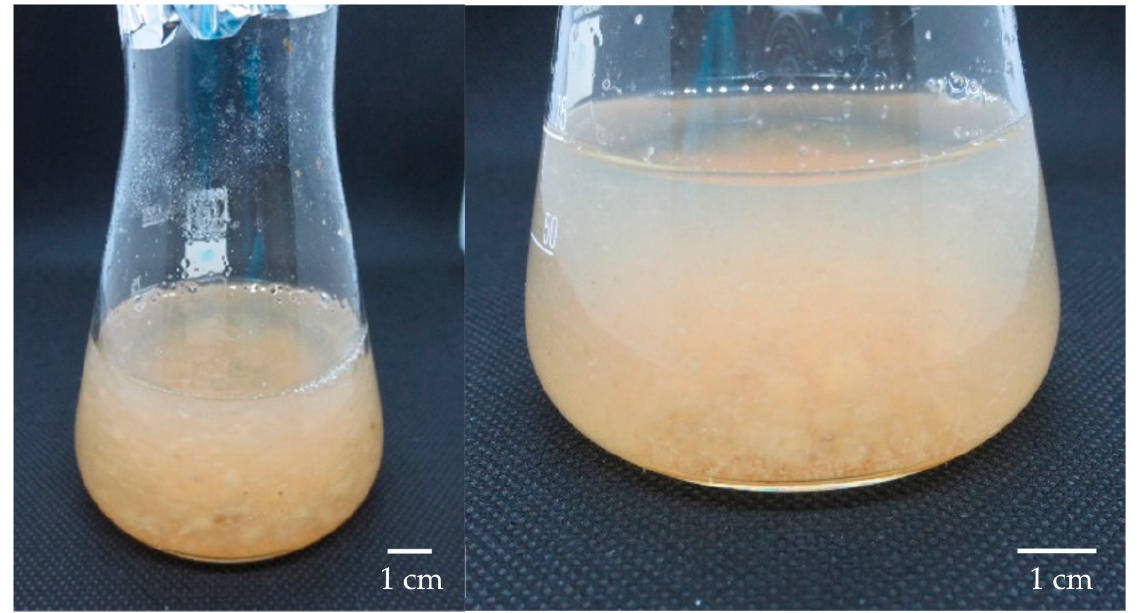
Figure 5. Fresh weights and medium pH of L. schweinfurthii cell cultures after 2 weeks of culture on 50 mL MS medium fortified with 2 mg L − 1 NAA. Inoculation weight was 1 g fresh callus per 50 mL liquid medium. Four replicates were used for each sucrose concentration.